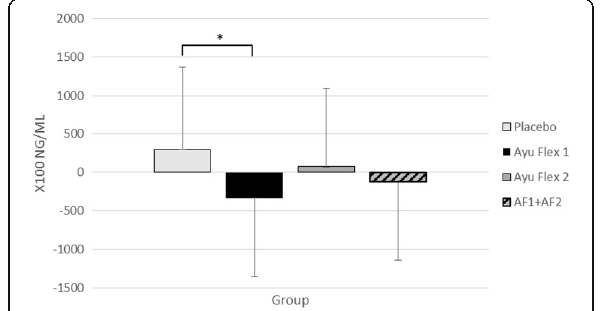
Fig. 12 Mean ± SD changes in serum concentrations of COMP. A significant difference was noted between AF1 vs. Placebo ( p =